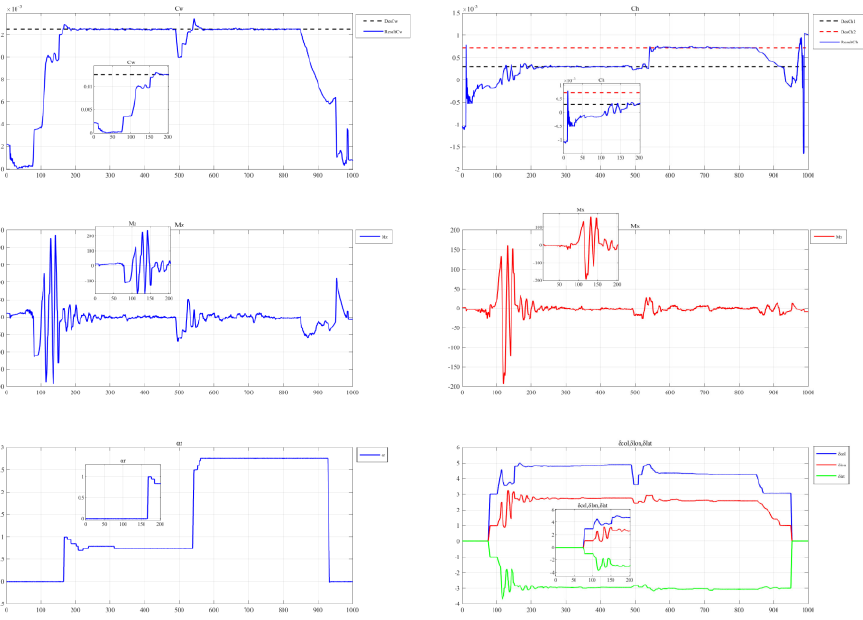
Figure 9. The results of the forward-flight trimming test.